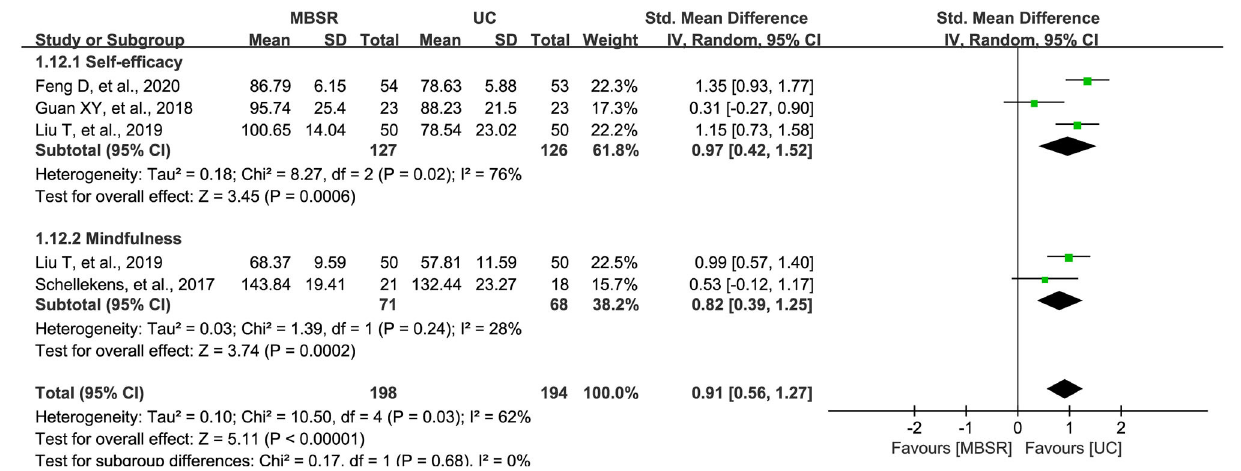
FIGURE 3 | Forest plot of comparative effectiveness between the MBSR program and UC in terms of positive psychological status. MBSR, mindfulness-based stress reduction; UC, usual care; SUPPH, strategies used by people to promote